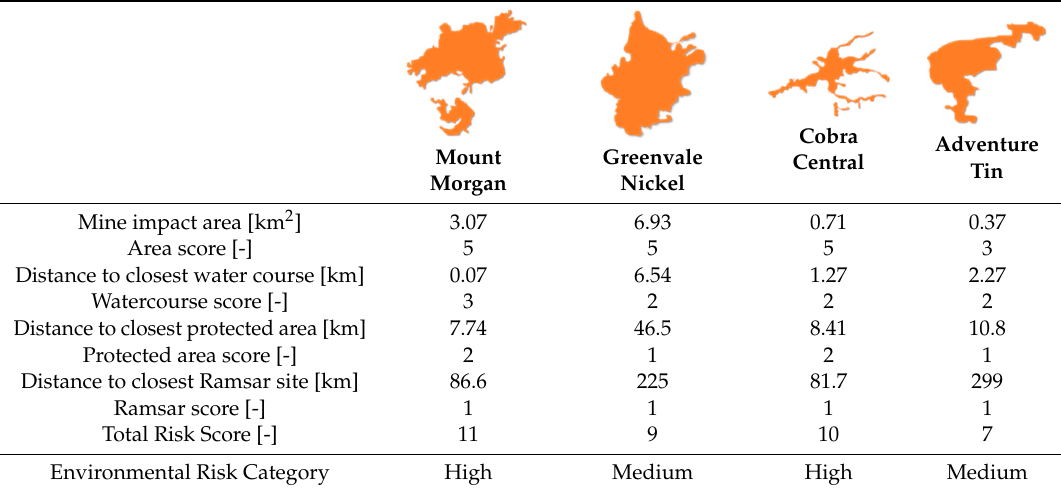
Table 4. Summary of environmental risk analysis for four neglected mine sites in Queensland, Australia. Each site is assigned a score for area, distance to closest water course, distance to closest protected area, and distance to closest Ramsar site, with a total risk score and Environmental Risk Category.